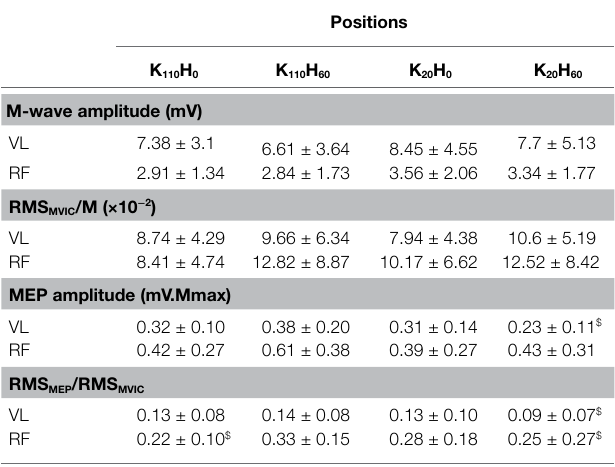
TABLE 1 | Electrophysiological parameters recorded for the vastus lateralis and rectus femoris muscles in the four positions ( n = 16; mean ± SD).